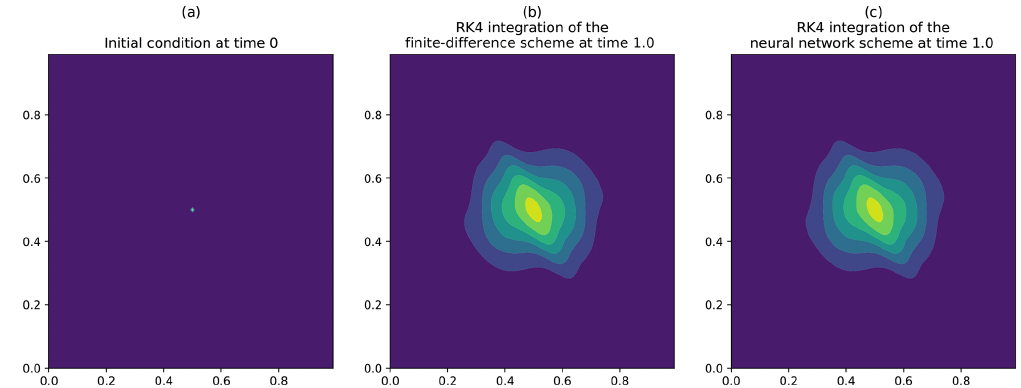
Figure 4. Starting from a Dirac (a) , the diffusion equation (Eq. 4) is integrated from 0 to 1 by using a fourth-order Runge–Kutta time scheme. The results obtained from the time integration of the finite-difference implementation in Eq. (5) (b) and of the generated NN representation (c) are